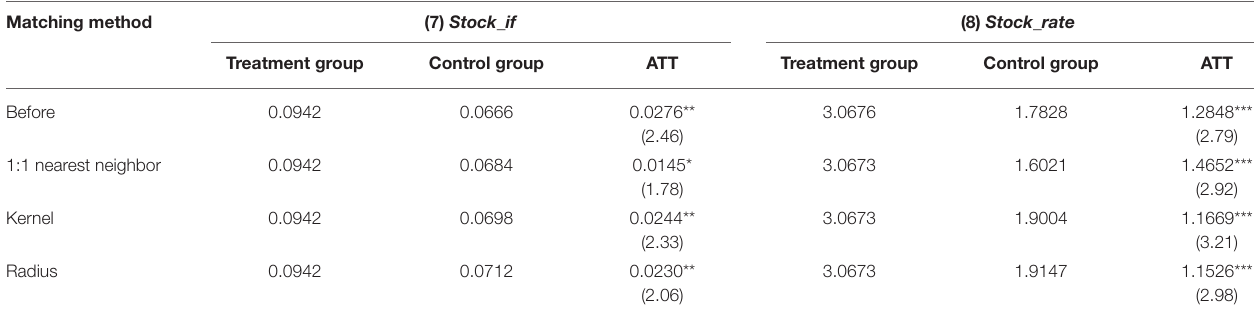
TABLE 5 | Endogenous test